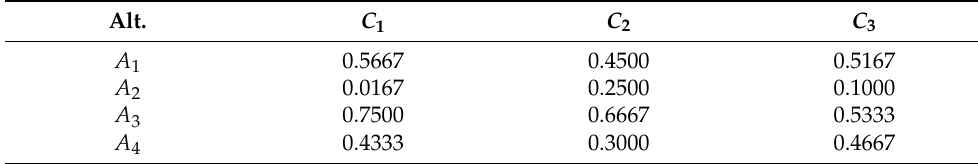
Table 8. Score values of the aggregated decision matrix.